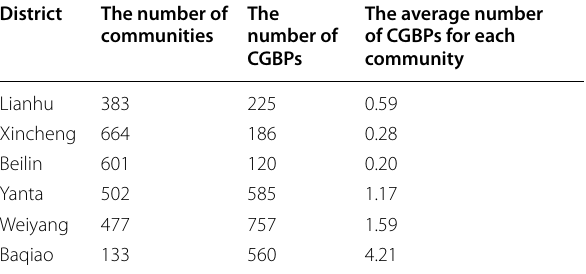
Table 6 The average number of CGBPs for each community in different districts District The number of The communities number of